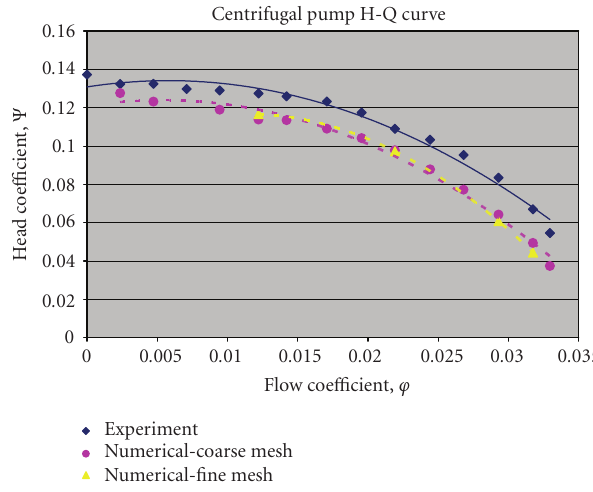
Figure 3: Comparison of numerical and experiment characteristics